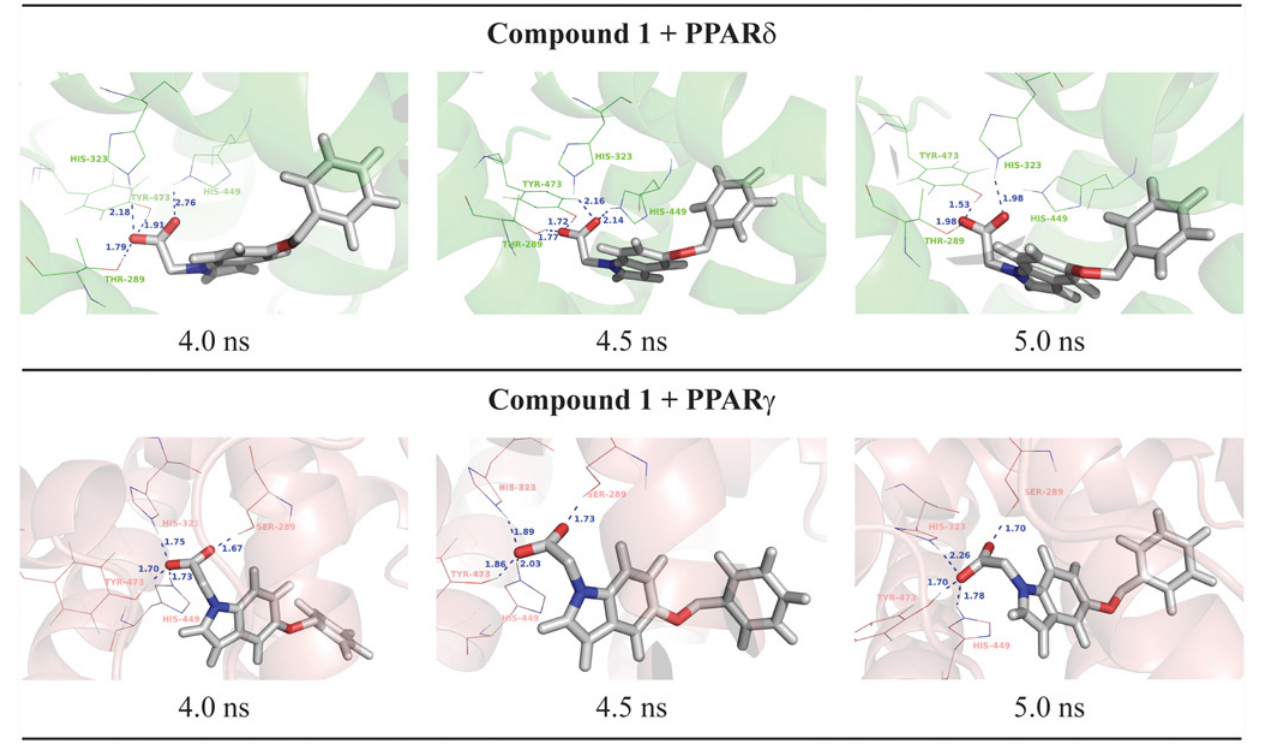
Fig 2. Final nanosecond snapshots of compound 1 molecular dynamic simulations in complex with PPAR subtypes. Main polar interactions between the compound 1 and the PPAR δ and PPAR γ during the final nanosecond of MD simulation.